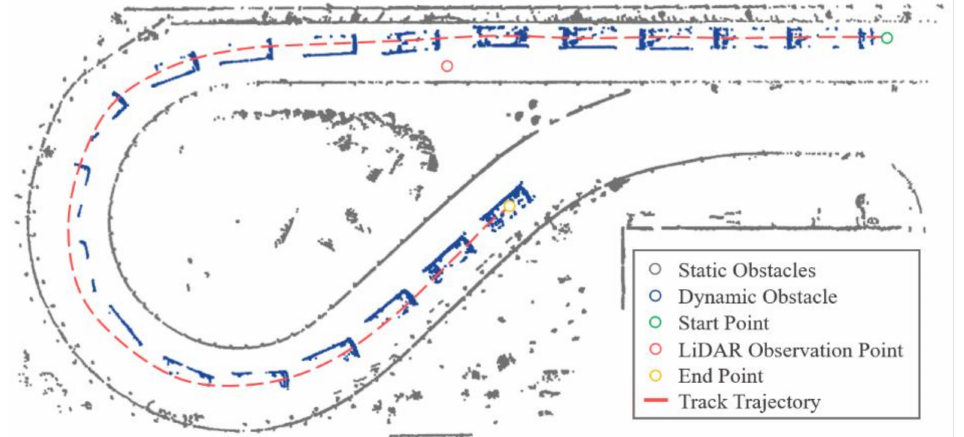
Figure 1. Point cloud scanning results of the same dynamic obstacle. When the obstacle vehicle gradually approaches our LiDAR observation point, the obstacle vehicle’s point cloud becomes dense. Otherwise, the point cloud becomes sparse. The obstacle vehicle shows L-shape, I-shape, C-shape, and other forms during this process. The variability of the point cloud’s distribution makes pose estimation